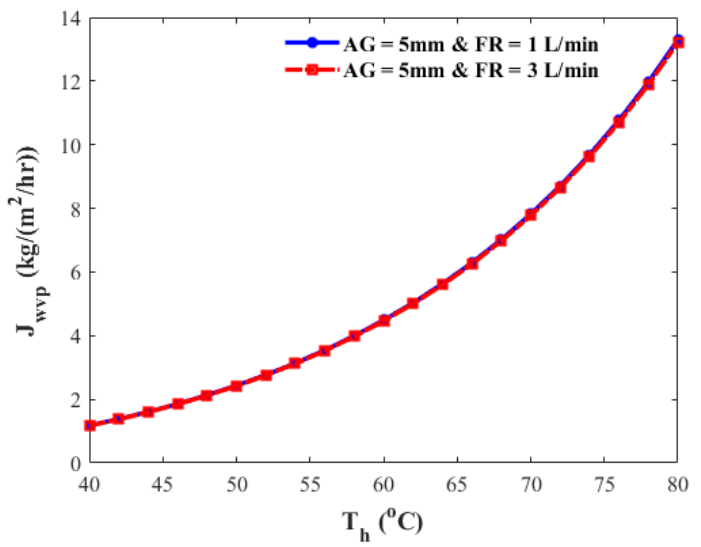
Figure 12. Effect of the cold feed (FR = 1 and 3 L/min) on the J wvp at different hot feed temperatures (T h ) (air gap thickness (AG) of 5 mm).